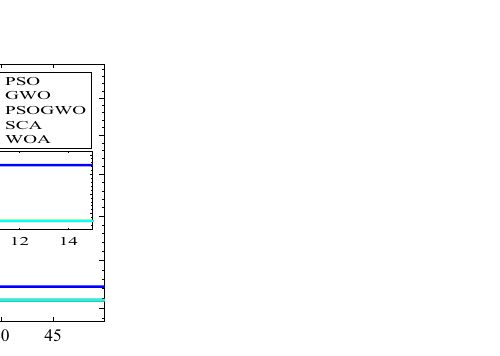
Table 2. Parameters of the optimization algorithm and boundary of decision variables of the objective function.